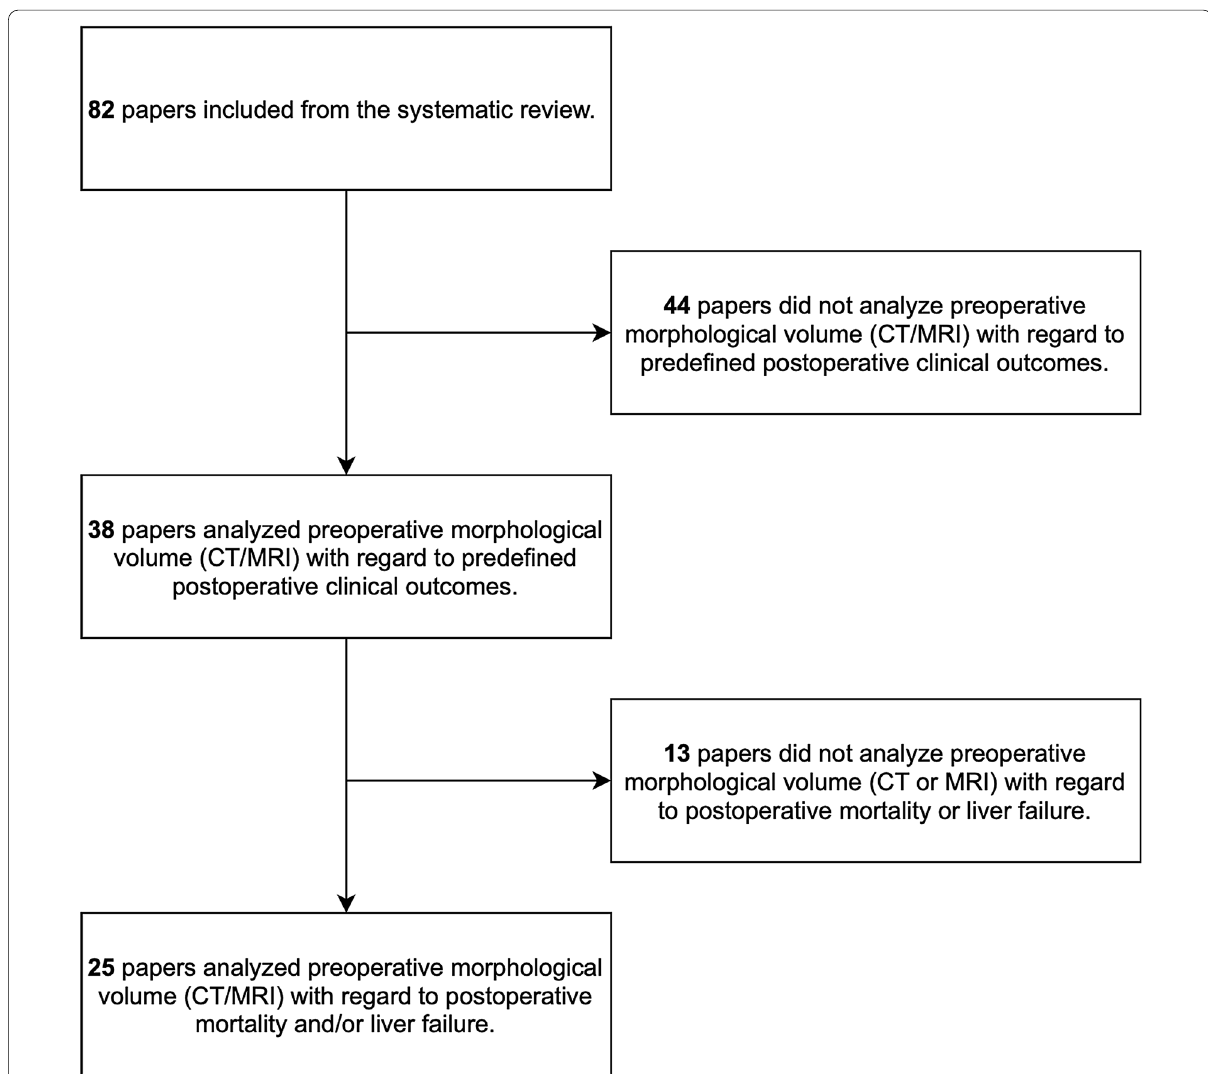
Fig. 1 Consort diagram of the inclusion of papers for this review. CT: computed tomography, MRI: magnetic resonance